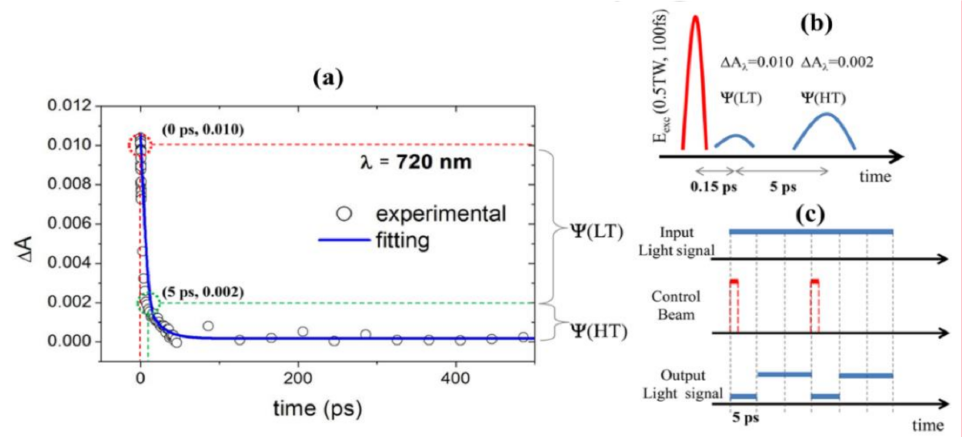
Figure 13. ( a ) Ultrafast TA of AgNp/Se bilayer at 720 nm. Hollow circles represent experimental data, and the solid blue line indicates theoretical fit, respectively. Following pump excitation, TA drops to 20% of its maximum value within 5 ps. ( b ) Schematics showing the effect of the pump (red) on the probe beam (blue). We define a low transmission state Ψ (LT) that corresponds to peak absorption, while 20% of peak absorption is defined as high transmission Ψ (HT) state. ( c ) Schematic demonstrating the application of the ultrafast response of AgNPs where the output probe transmission can be modulated using a control pump beam. All Figures are reprinted with permission from [67] Copyright 2013, American Institute of